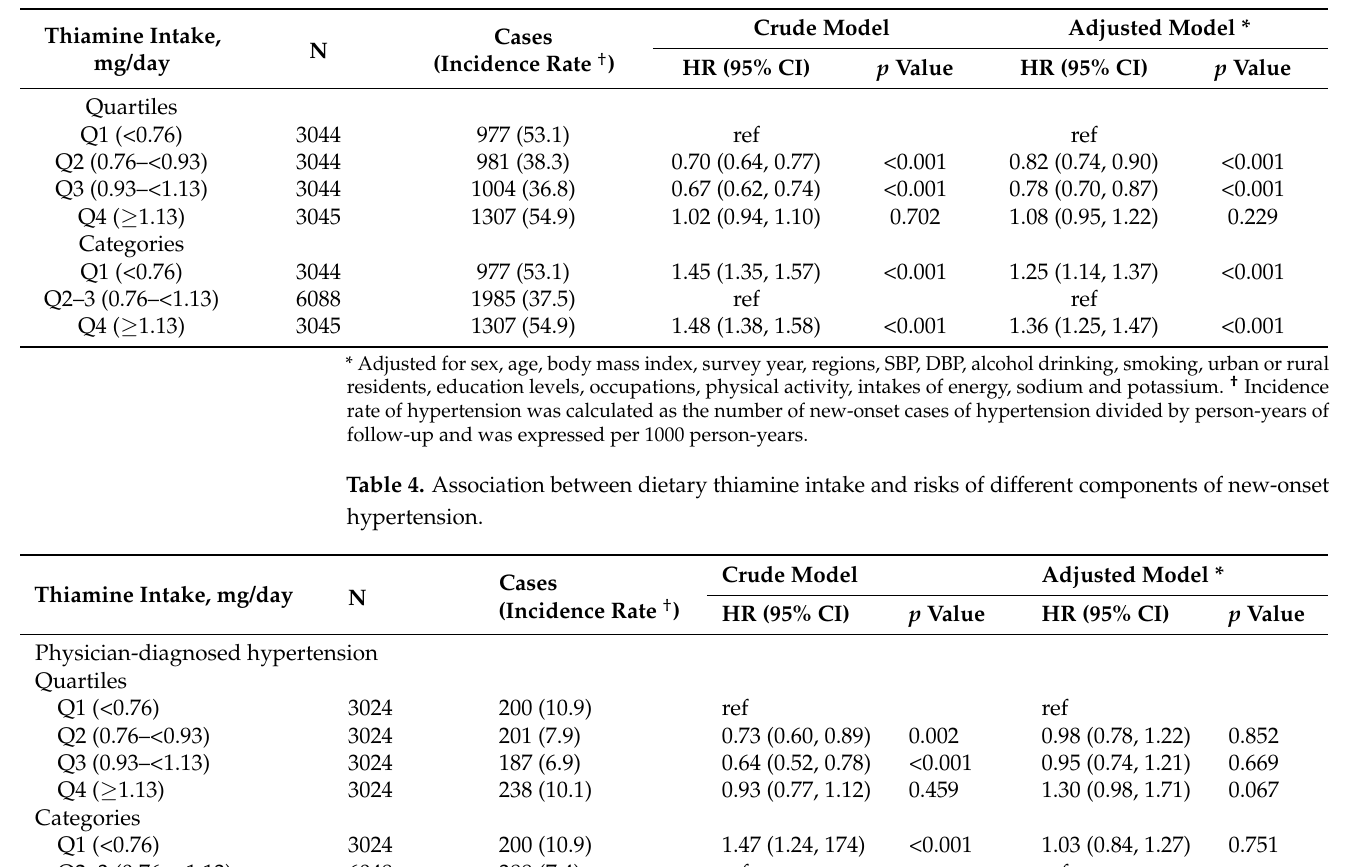
Figure 1. Association between dietary thiamine intake and new-onset hypertension. Adjusted for sex, age, body mass index, survey year, regions, SBP, DBP, alcohol drinking, smoking, urban or rural residents, education levels, occupations, physical activity, intakes of energy, sodium and potassium. Grey area indicates the 95% confidence interval. Table 3. Association between dietary thiamine intake and new-onset hypertension. Table 2. Threshold analyses of dietary thiamine intake (per SD increment, 0.35 mg/day) on new- onset hypertension using 2-piecewise regression models.